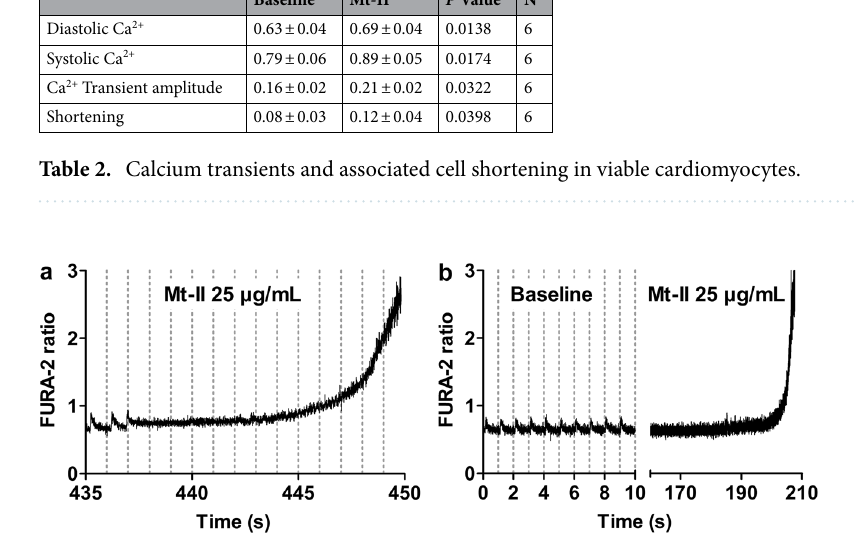
Figure 5. Mt-II induced cell hypercontraction is characterized by a massive increase of intracellular calcium concentration, regardless of presence or absence of electrical cell stimulation. Vertical dotted lines in a and b show the timing of electrical stimuli. ( a ) Calcium transients of the cell presented in Fig. 4a,b after 434 s of Mt-II exposure. Striation pattern was lost at 434 s, making sarcomere length acquisition no longer possible. Few calcium transients were still registered before the cell became stagnant to the electrical stimulus for several seconds. Note also the delayed calcium transient at 435 and 436 s. Finally, a massive increase of intracellular calcium was registered, which occurred simultaneously with the hypercontraction of the cell. ( b ) Intracellular calcium concentration of an intact cardiomyocyte exposed to Mt-II in absence of electrical stimulation. The left segment of the X-axis corresponds to the first ten seconds of the baseline phase (total baseline time 60 s). Electrical stimuli were applied only during the first ten seconds in order to confirm cell responsiveness. Thereafter, the electrical pacer was turned off and FURA-2 signal acquisition was continued. The right segment of the X-axis corresponds to Mt-II exposure, after 1 min baseline. There were no calcium transients because an electrical stimulation was not administrated. Again, a massive increase of intracellular calcium at time of hypercontraction was observed, as in presence of electrical stimulation in ( a ). The apparently different slopes of data in ( a , b ) obey mostly to the different time scales used. All cells exposed to these conditions presented the same behavior, including some variation of the time interval until hypercontraction at a given Mt-II concentration, as shown in Fig. 2a. Image created using GraphPad Prism (version 5.01) www. graph pad.